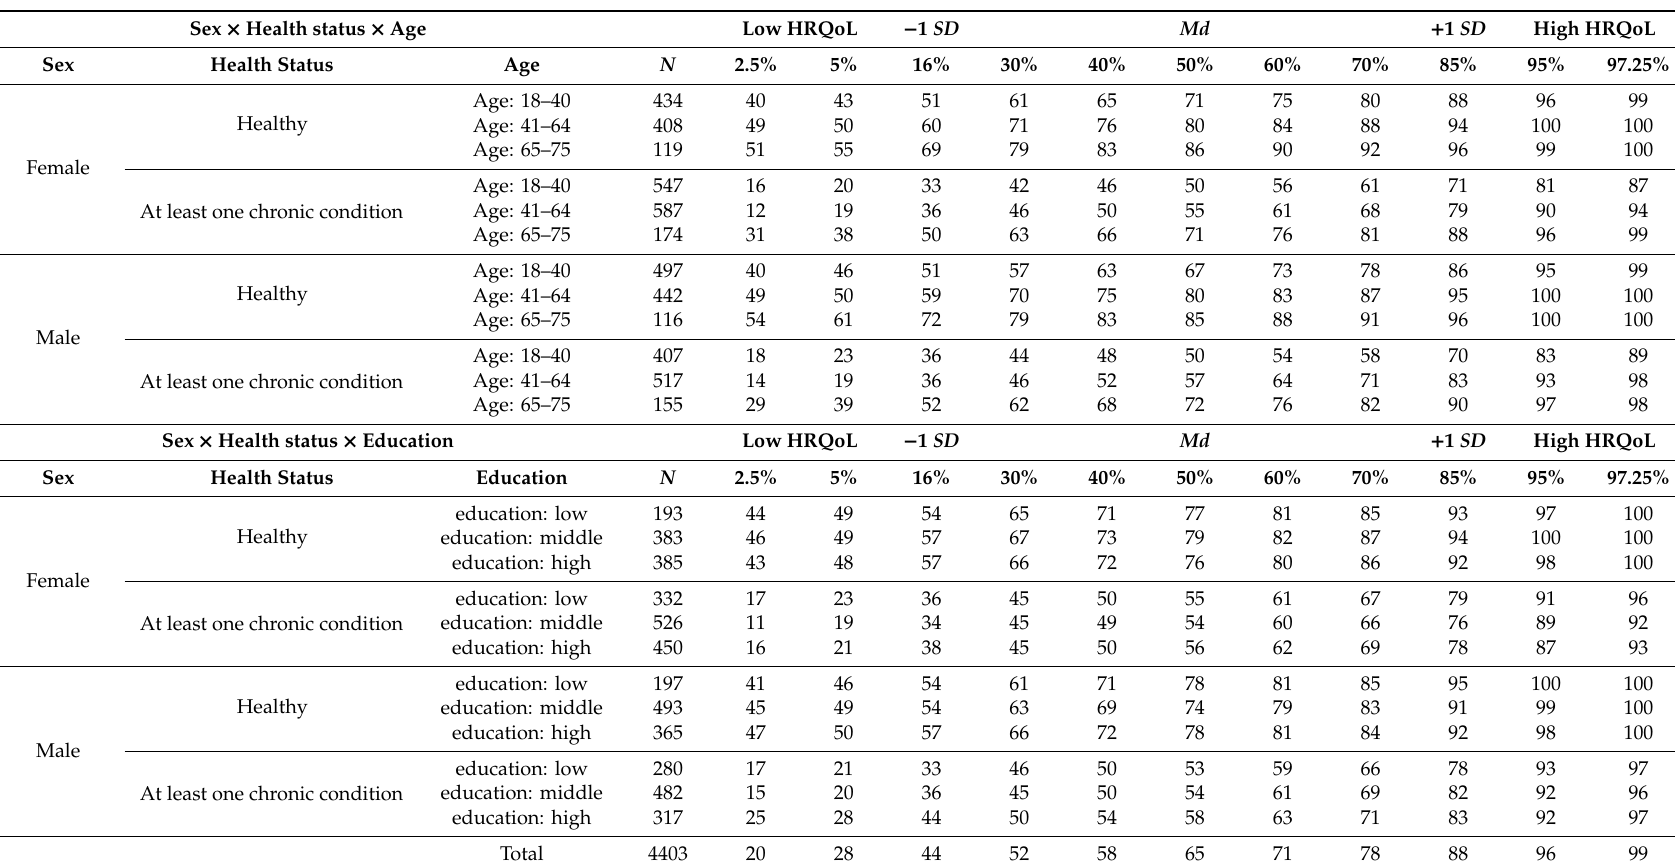
Table 3. Reference values for the Quality of Life after Traumatic Brain Injury (QOLIBRI) total score obtained from the general population UK sample stratified by sex, health status, age, and